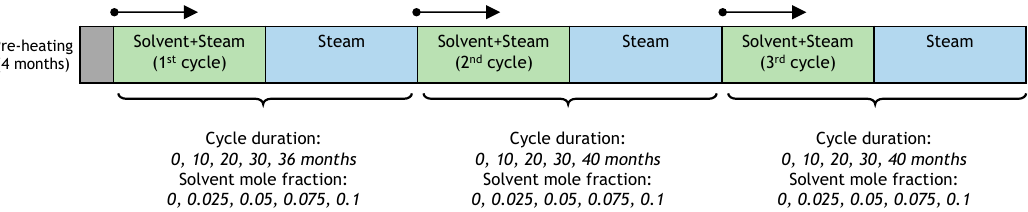
Figure 16. Changes in the duration and solvent concentration for each of the steam-solvent cycles.